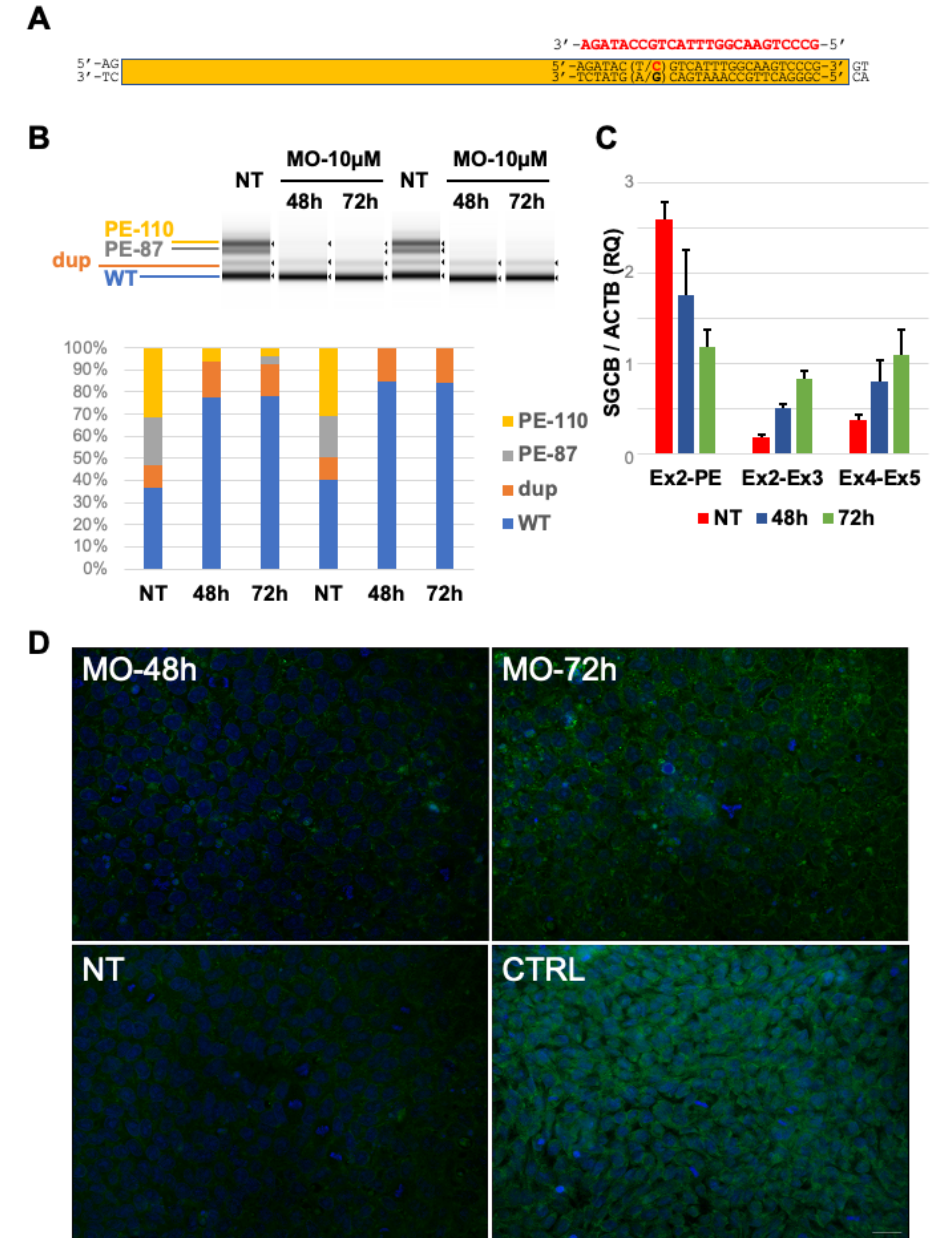
Figure 3. Splicing defect rescue by in vitro morpholino treatment: ( A ) Scheme of the pseudoexon and localization of the Morpholino sequence (MO, in red) used in this study. ( B ) Tape Station analysis of RT-PCR amplicons obtained in untreated (NT) and treated (MO) patient’s derived induced pluripotent stem cells documenting the amelioration of physiological splicing and the reduction in aberrant splicing products after MO delivery. Tape Station analysis allowed the identification of two additional bands corresponding to a predicted shorter form of Pseudoexon (PE-87) and a band with a molecular weight corresponding to the SGCB transcript containing the c.377_384dup duplication (dup). ( C ) qRT-PCR analysis of SGCB transcripts encompassing different exon junctions in untreated (NT) patient’s derived iPSCs and in Morpholino (MO)-treated cells displaying the increase in physiological splicing and the concomitant reduction in aberrant transcripts including Exon2-PE junction. ( D ) Immunocytochemical analysis of beta-sarcoglycan signal in untreated patient’s derived iPSCs (NT), in Morpholino (MO)-treated cells, and in iPSCs obtained from a control subject (CTRL). Magnification 40×. Scale bar 50 μ m.